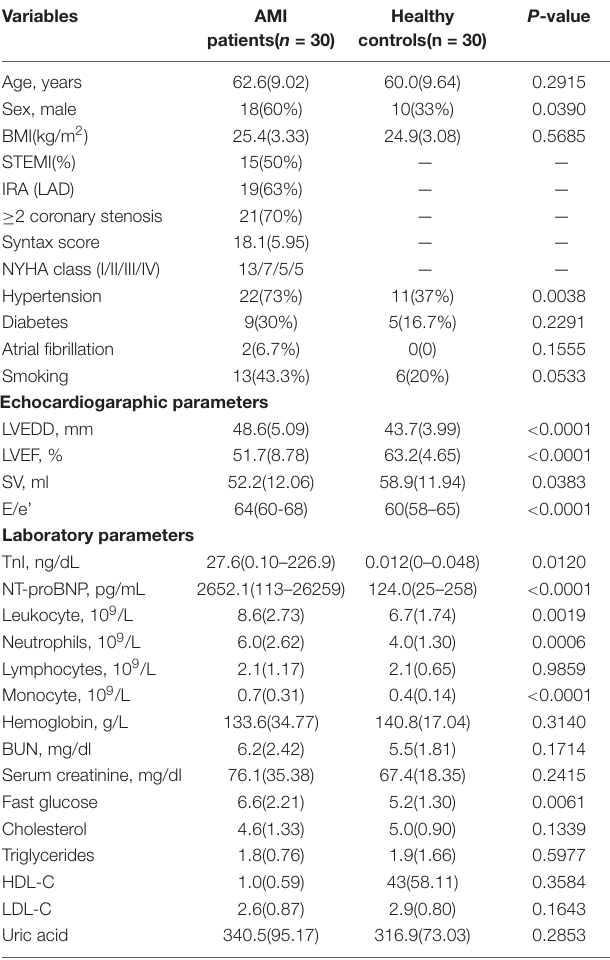
TABLE 1 | Baseline characteristics of the study